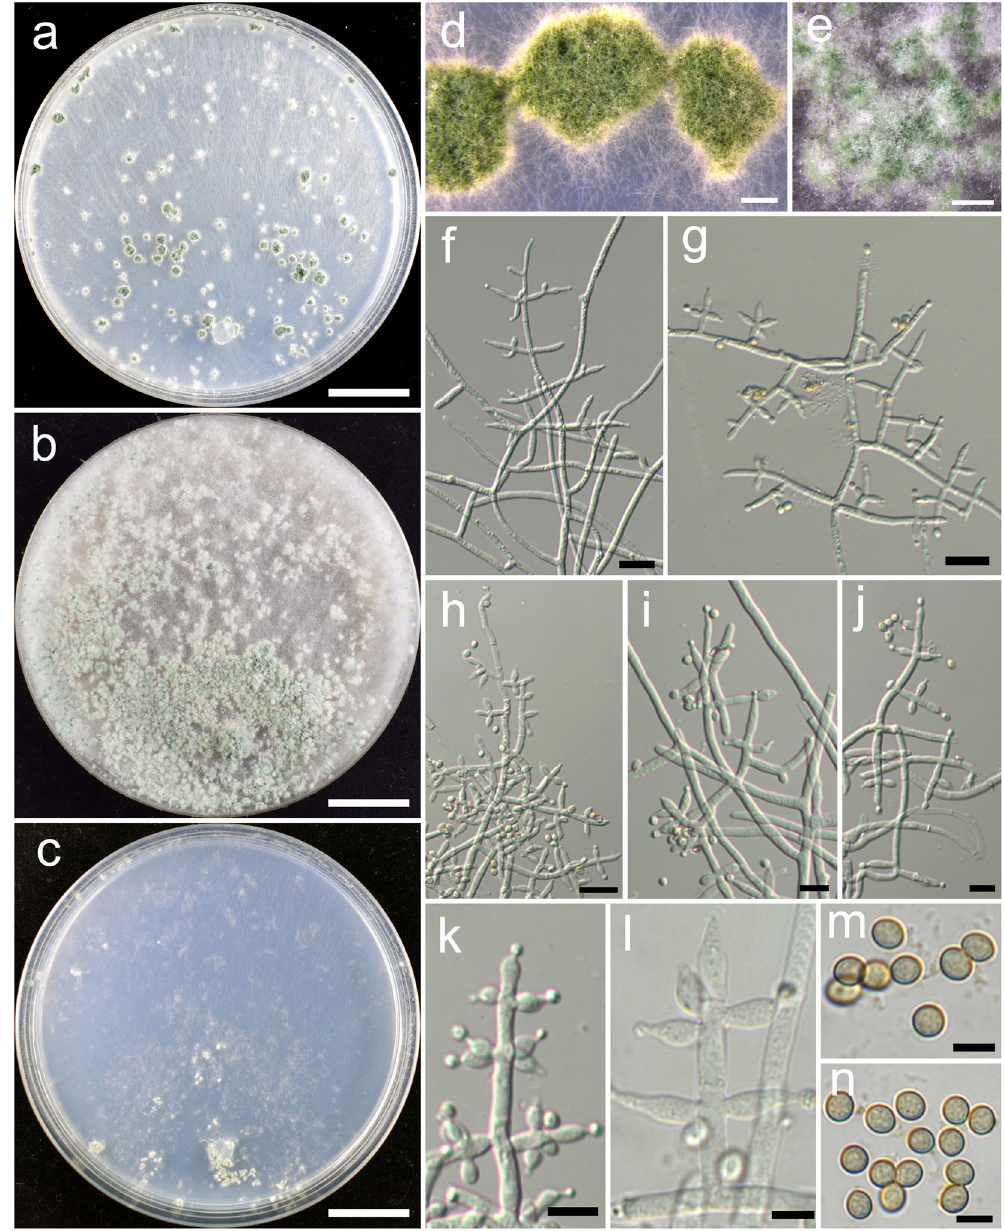
Figure 6. Trichoderma brevicrassum (HMAS 248871). ( a – c ) Cultures at 25 °C (a. on CMD, 10 d; b. on PDA, 10 d; c. on SNA, 15 d); ( d – e ) Conidial pustules (d. CMD, 10 d; e. PDA, 10 d); ( f – l ) Conidiophores and phialides (f–j, l. PDA, 4 d; k. CMD, 7 d); ( m – n ) Conidia (PDA, 4 d). Bars: a–c = 20 mm. d = 600 μ m. e = 1 mm. f–h = 20 μ m. i–k = 10 μ m. l–n = 5 μ